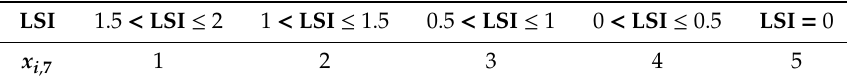
Table 7. Performance values x i ,7 for 7th